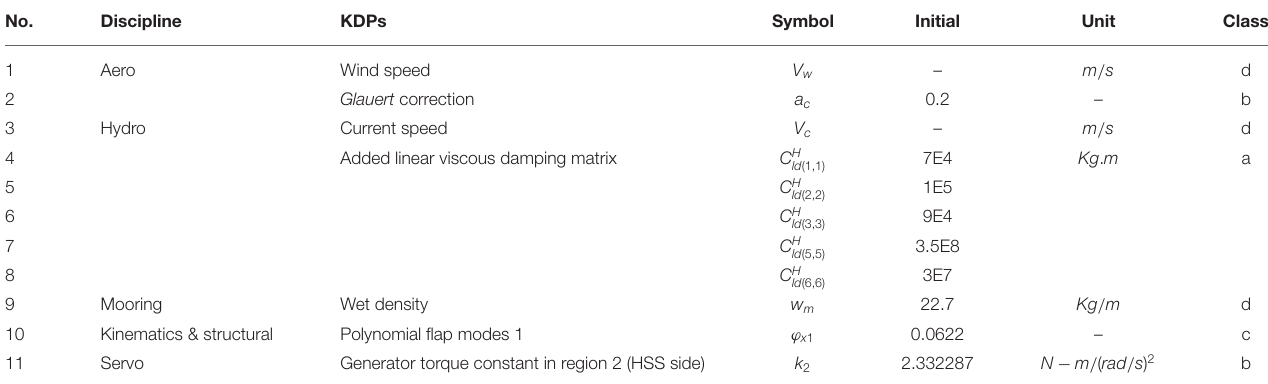
TABLE 2 | KDPs in